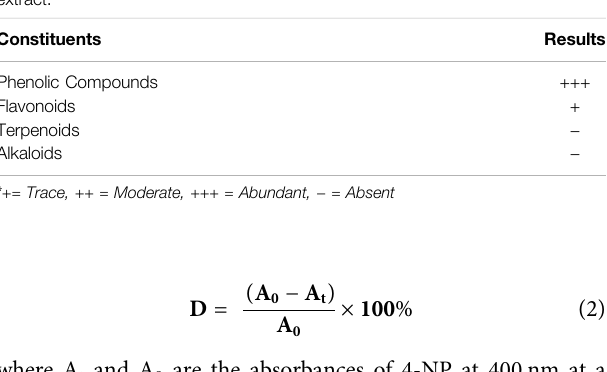
Frontiers in Chemistry |